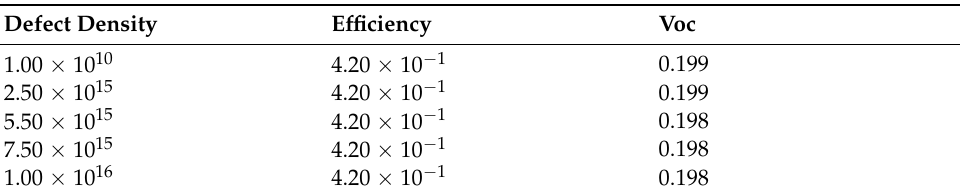
Table 4. Effect on efficiency and Voc with defect density.